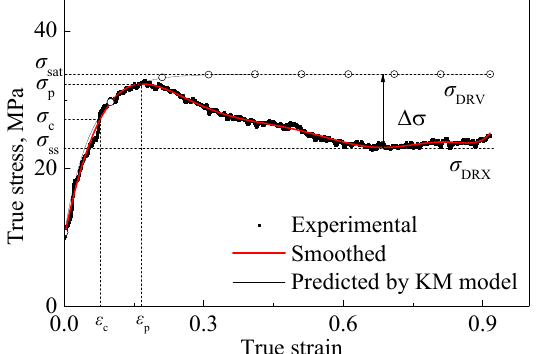
Figure 3. Schematic description of the flow behavior of 316LN at high temperature T = 1150 °C/ ε = 0.001 s − 1 ( σ sat is the saturation stress; σ ss is the steady state stress of the experimental data; σ c is the critical stress; σ p is the peak stress; ε c is the critical strain; ε p is the peak strain; Δσ = σ sat − σ ss ). When the dislocation density ρ of the material reaches the dynamic balance, the flow stress tends towards the saturation stress σ sat . During the entire process of deformation, work hardening occurs as a result of the refinement of the microstructure caused by the increased strain, and thus the flow stress can be described by: